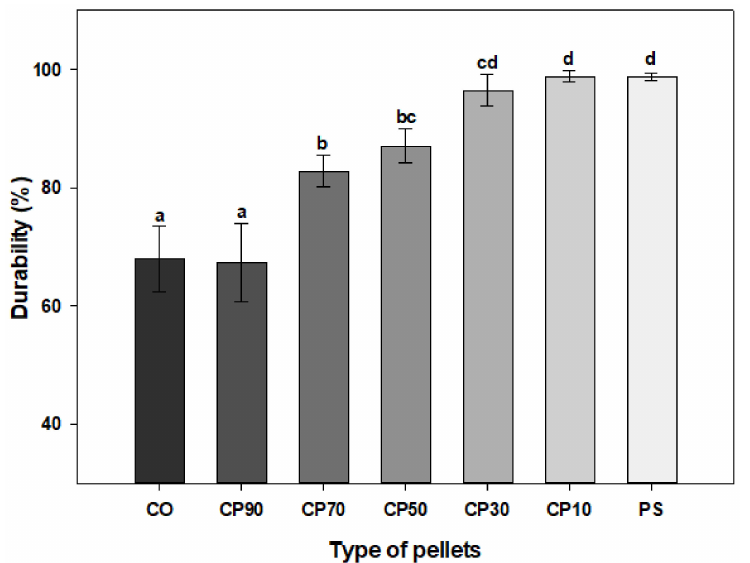
Figure 6. Pellet durability according to SCG blending ratio. Each point is the mean of three repeated measurements and is the mean ± standard deviation. The means with different letters (a–d) above the bars indicate significant differences based on Tukey’s HSD test ( p <